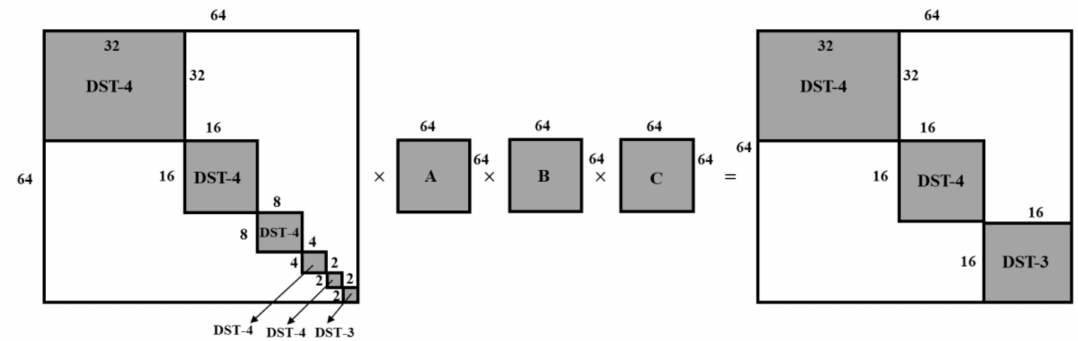
Figure 4. Proposed method to obtain the 16-point DST-3 transform